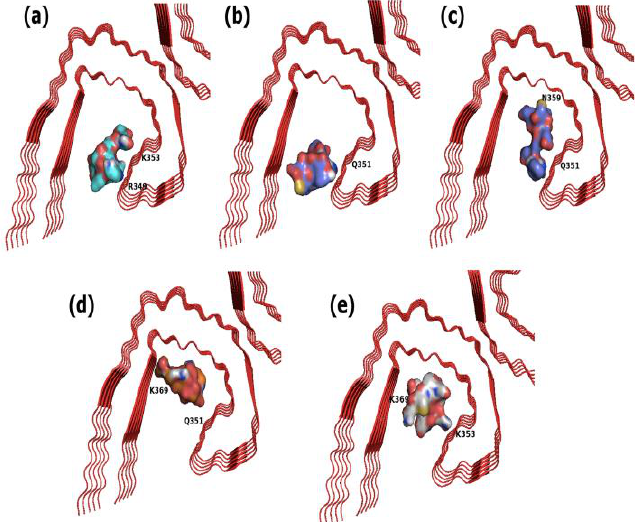
Figure 4. Results obtained from docking studies showing the best binding modes for ( a ) TauRP1-2 (mode 6); ( b ) TauRP1-4 (mode1); ( c ) TauRP1-4 (mode 2); ( d ) TauRP1-8 (mode 3); ( e ) TauRP1-4 (mode 2) with PHF Tau.